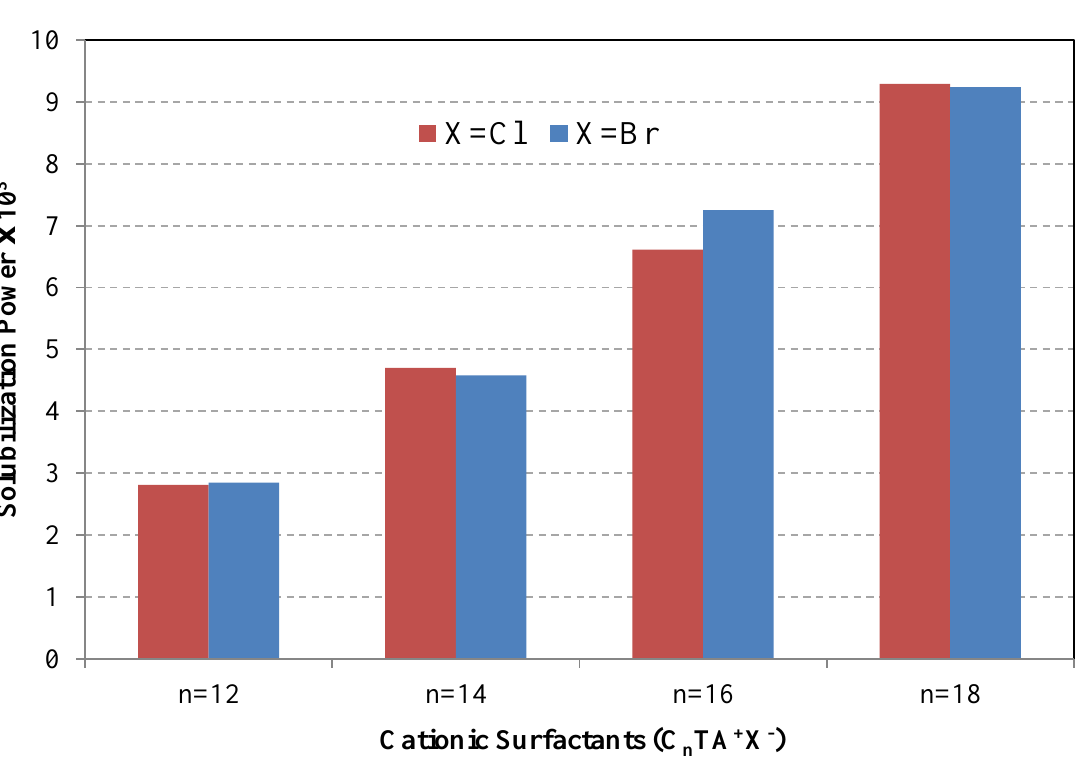
TA + X − ; n = 12,14,16,18 and X = Cl, Br) at 25  C. Data n